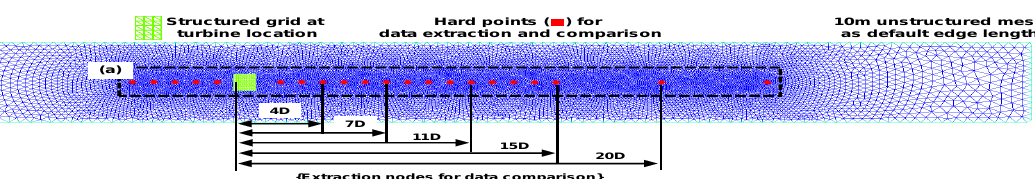
Figure 4. x – y horizontal plane illustrating the geometry mesh. The structured grid is used to define the enclosure of the actuator disc, while the rest of the domain is enforced using the unstructured mesh. The turbine is located at 250-m from the channel inlet. Selected downstream nodes that were used in the data extraction and validation purposes are represented by the red points along the turbine centreline in terms of the turbine diameter, D. The dotted rectangle outlines the zone ( a ) where the mesh refinement (min = 1 m, max = 10 m) was administered.